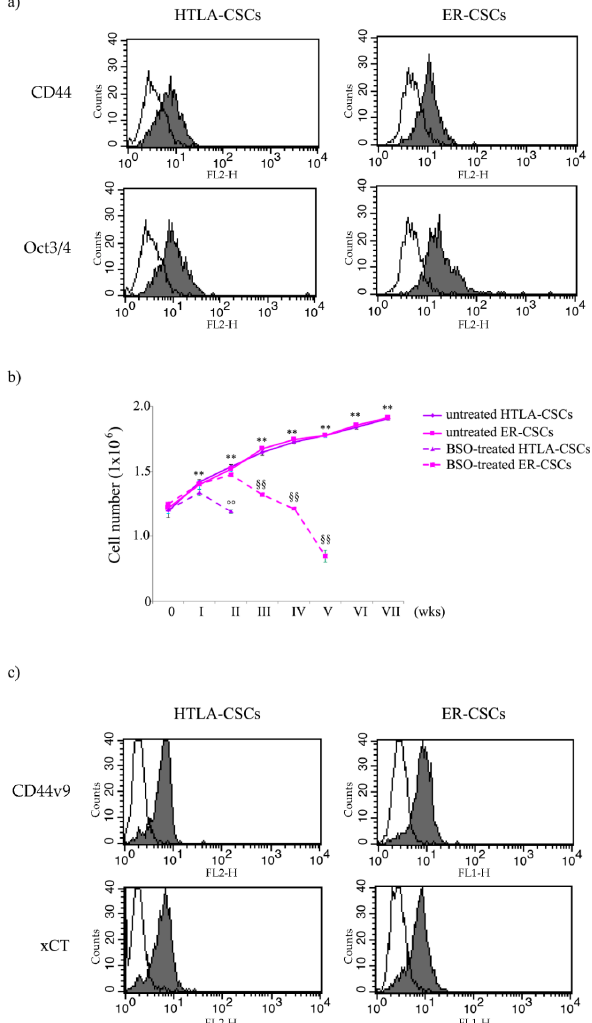
Figure 1. Flow cytometric analysis of CD44, Oct3/4 ( a ) and of CD44v9 and xCT ( c ) expression in untreated HTLA-CSCs and ER-CSCs. Cells were permeabilized, stained with mAbs to the indicated molecules, and analyzed by flow cytometry. Grey profiles indicate cells stained with the different mAbs, while white profiles correspond to isotype control. One representative experiment of five is shown. ( b ) Evaluation of cell number in HTLA-CSCs and ER-CSCs chronically treated with 1mM BSO. Both CSC populations were treated (once a week for six weeks) with 1 mM BSO and, at any split, disaggregated CSCs were counted using a Burker chamber as described in Materials and